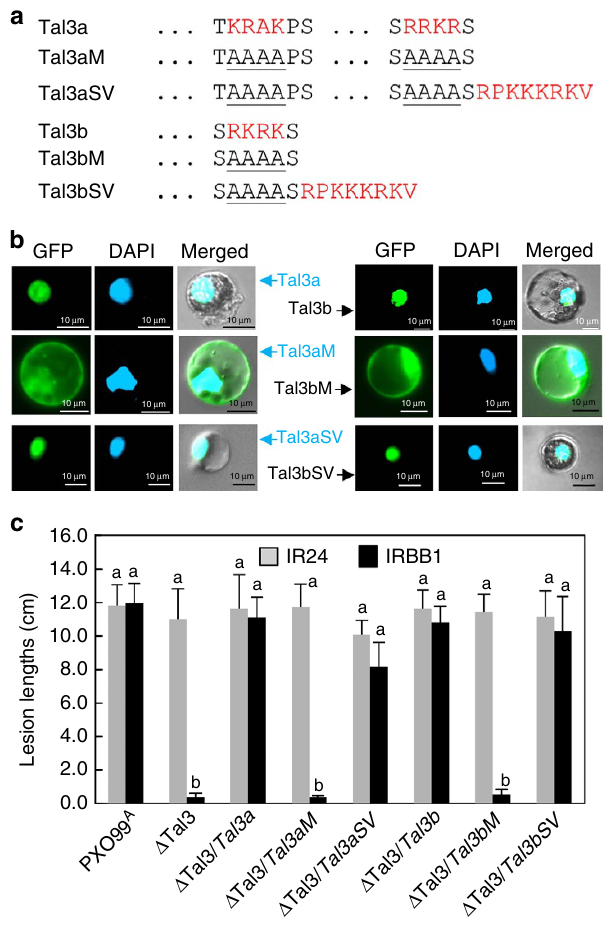
Figure 4 | Nuclear localization motifs in Tal3a and Tal3b are required for their suppressive activities. ( a ) Amino acids at the NLS and replacements are in red and underlined. ( b ) NLS motifs in Tal3a and Tal3b are functional to direct the GFP-tagged effectors into nuclei of rice protoplasts. ( c ) NLS motifs are required for Tal3a and Tal3b to interfere with the Tal3 triggered resistance in IRBB1. Lesion lengths of rice leaves caused by different strains as indicated below each column and measured at 12 DPI. Error bars indicate s.d. ( n ¼ 9, 3 replicates) with the same letters not different from each other at P o 0.05 (Tukey’s